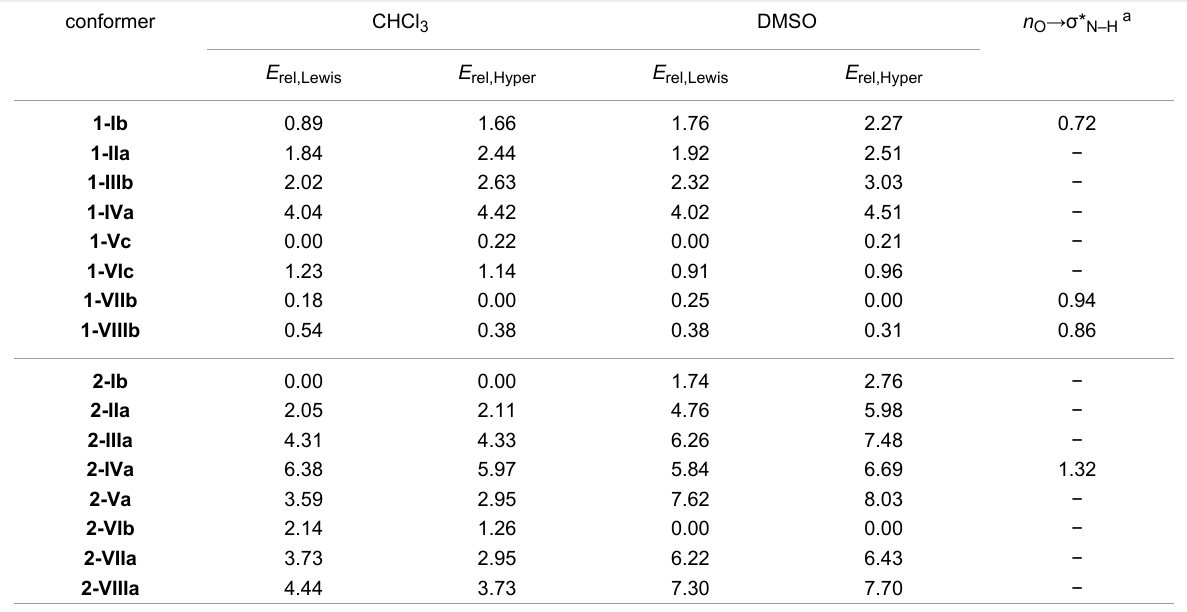
Table 4: Calculated NBO parameters ( ω B97X-D/aug-cc-pVTZ) for the most stable conformers of the compounds 1 and 2 . Relative energy of the steric ( E rel,Lewis ) and hyperconjugative ( E rel,Hyper ) interactions are given in kcal mol − 1 . The sum of E rel,Lewis and E rel,Hyper is the total energy of the